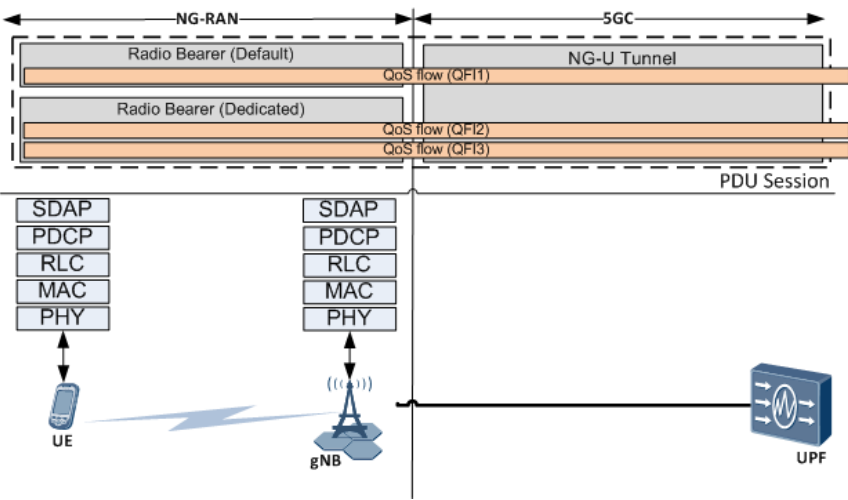
Figure 7. 5G NG-RAN Protocol Stack and 5G QoS